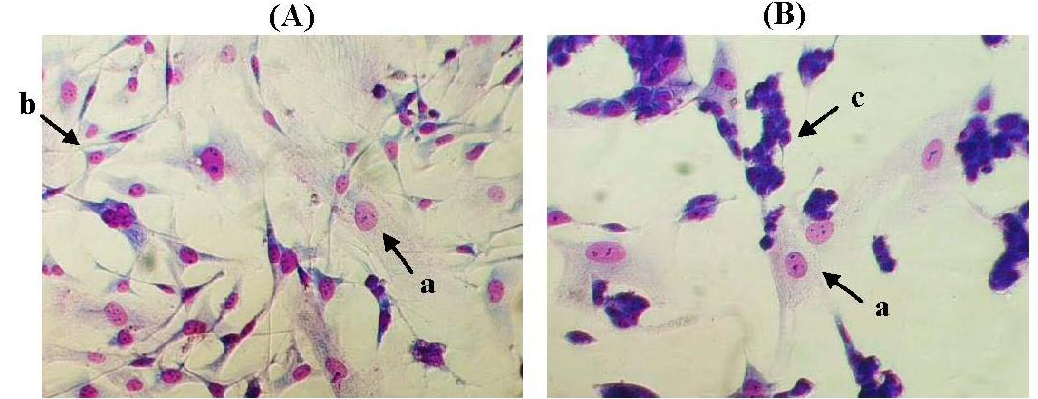
Figure 1. Co-culture of ( A ) MDA-MB-231 cells with MCF-10A cells, and ( B ) BT-474 cells with MCF-10A cells. The BT-474 cells can easily be distinguished from MCF-10A cells, whereas the epithelial-like morphology of MDA-MB-231 cells is not easily distinguishable. The pictures were taken at 40% cell confluence with 200x magnification, where 0.01 mm was equal to 10 µm. a : MCF-10A cells, b : MDA-MB-231 cells and c : BT-474